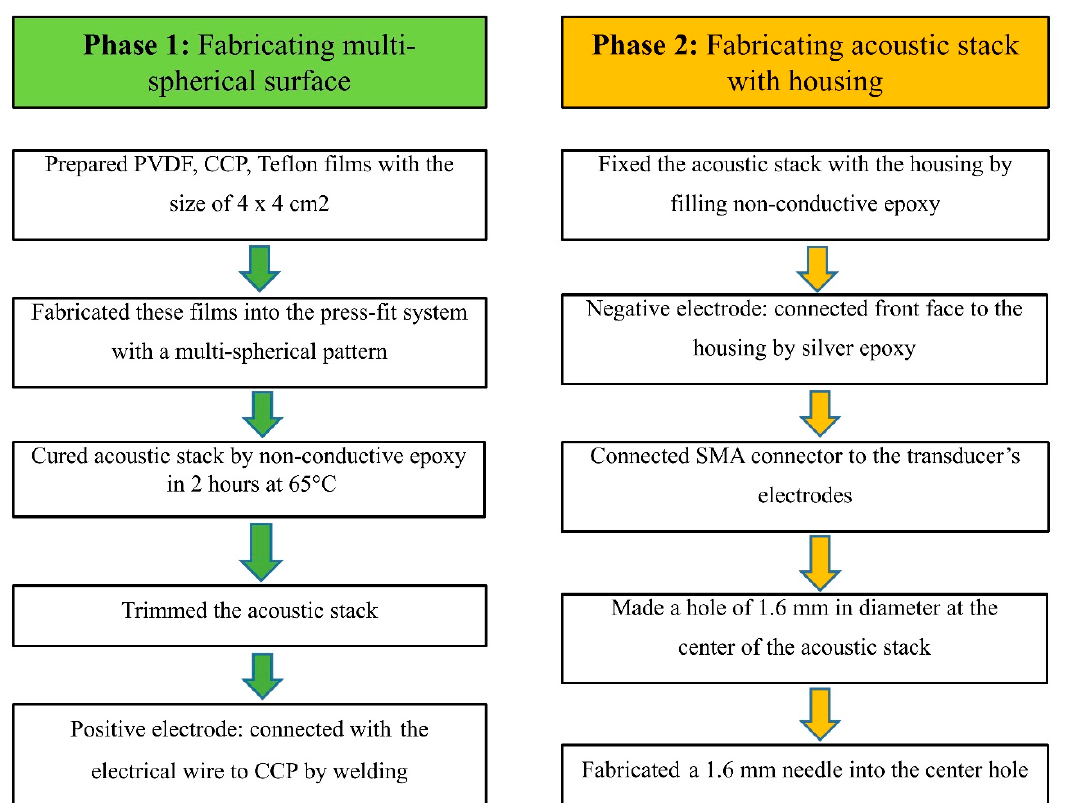
Figure 4. The fabrication process of the ring-shaped MFP transducer.